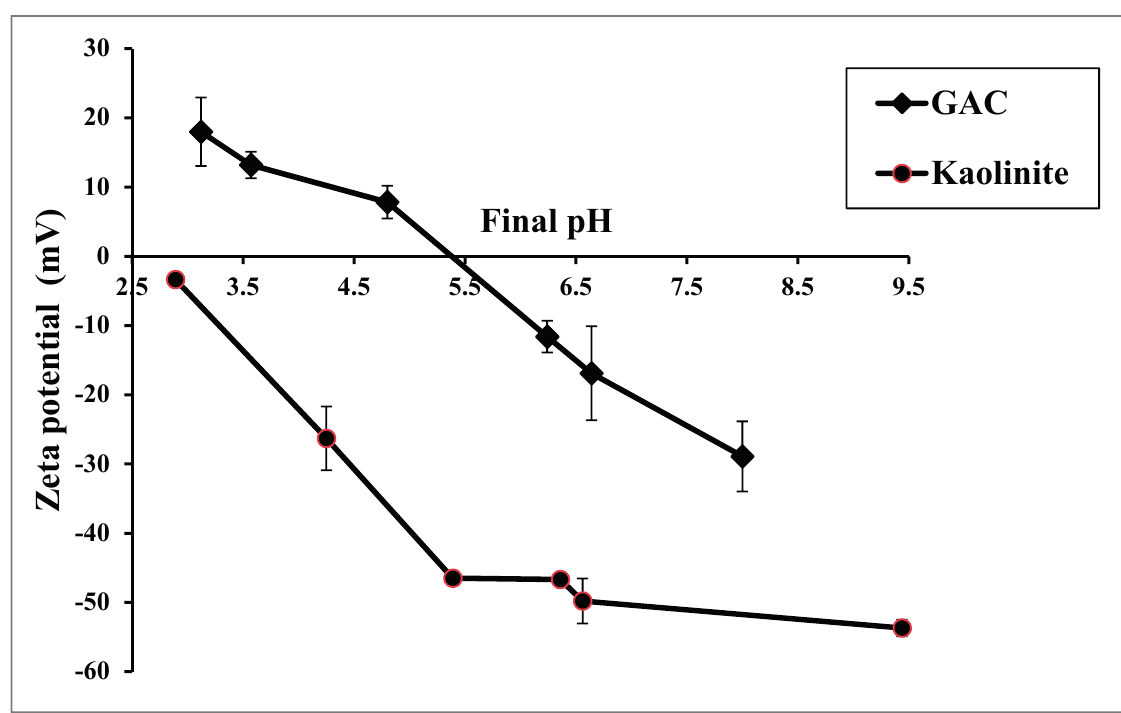
Figure 1. Mean zeta potential values of GAC and kaolinite at different pH values in